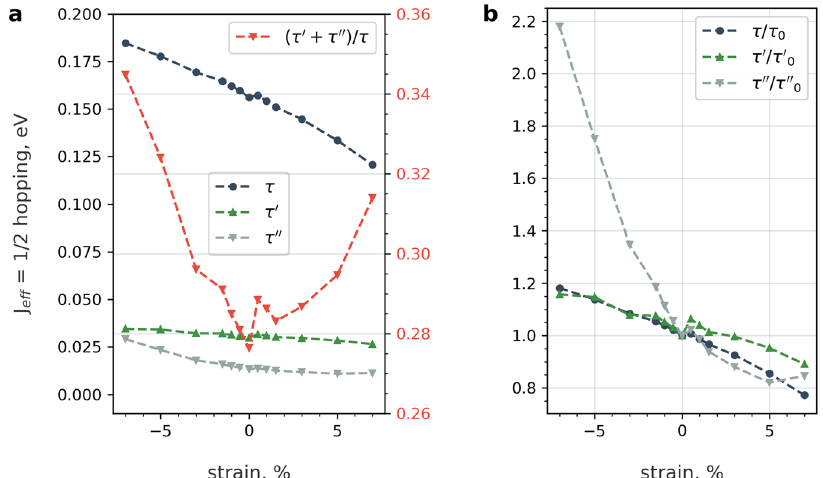
Fig. 5 Dependency of J eff = 1/2 overlap on the strain. a NN, 2NN and 3NN hopping parameters ( τ , τ 0 and τ ″ , correspondingly) between J eff = 1/2 states calculated as a superposition of obtained from DFT calculations xy , yz , and xz hopping parameters. b Relative change of NN, 2NN, and 3NN J eff = 1/2 overlap normalized by their values in pristine condition ( τ 0 , τ 0 and τ ″ , correspondingly. 2NN and 3NN hoppings for t 2g orbitals used to calculate τ 's are shown in